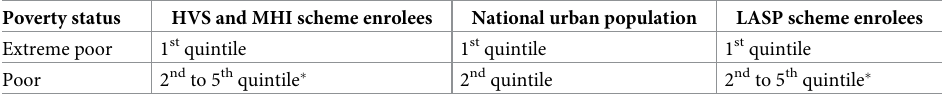
Table 3. Definition of poverty